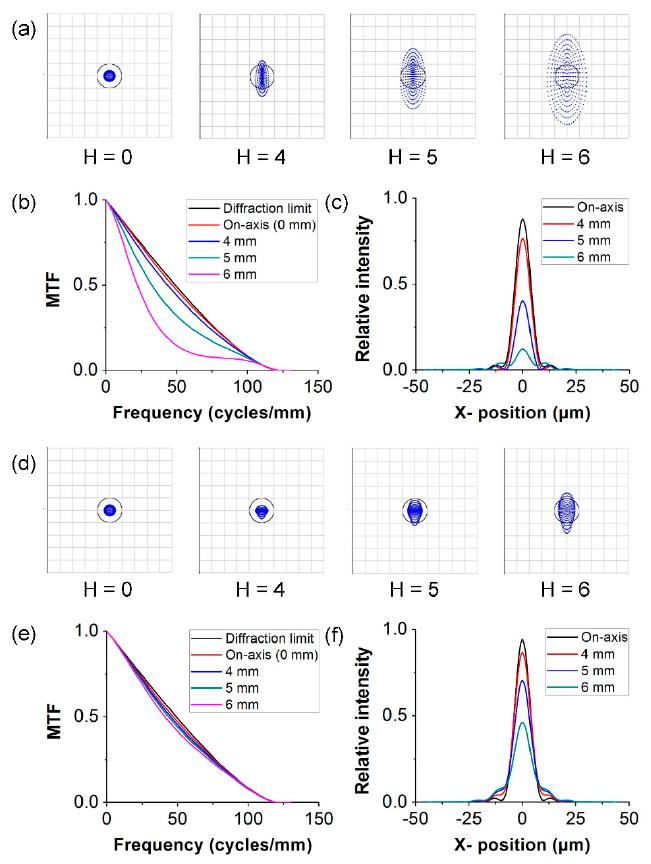
Figure 5. Analytical characterization of simple imaging system for flat and curved substrates. The spot size diagrams include a circle showing the Airy disk (9.87 µ m in radius) for the flat and the curved substrates in ( a , d ), respectively. ( b , e ) MTF and ( c , f ) PSF of flat and curved substrates, respectively. In the MTFs, the black line shows the diffraction limit, and the red and pink lines represent the on- and off-axis image fields,